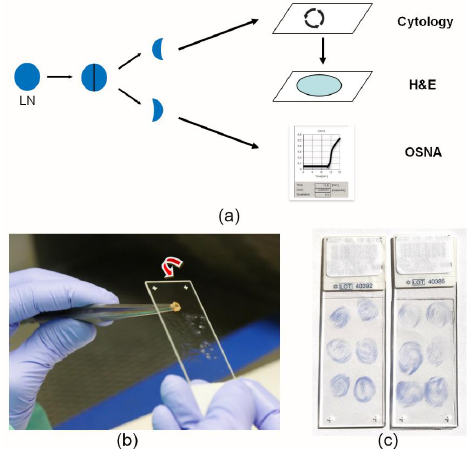
Figure 1. Fresh lymph node analysis with three methods, cytology smears, H&E, and OSNA. ( a ) Dissected lymph nodes were bisected. A cytology smear was performed on a pre-treated slide, and